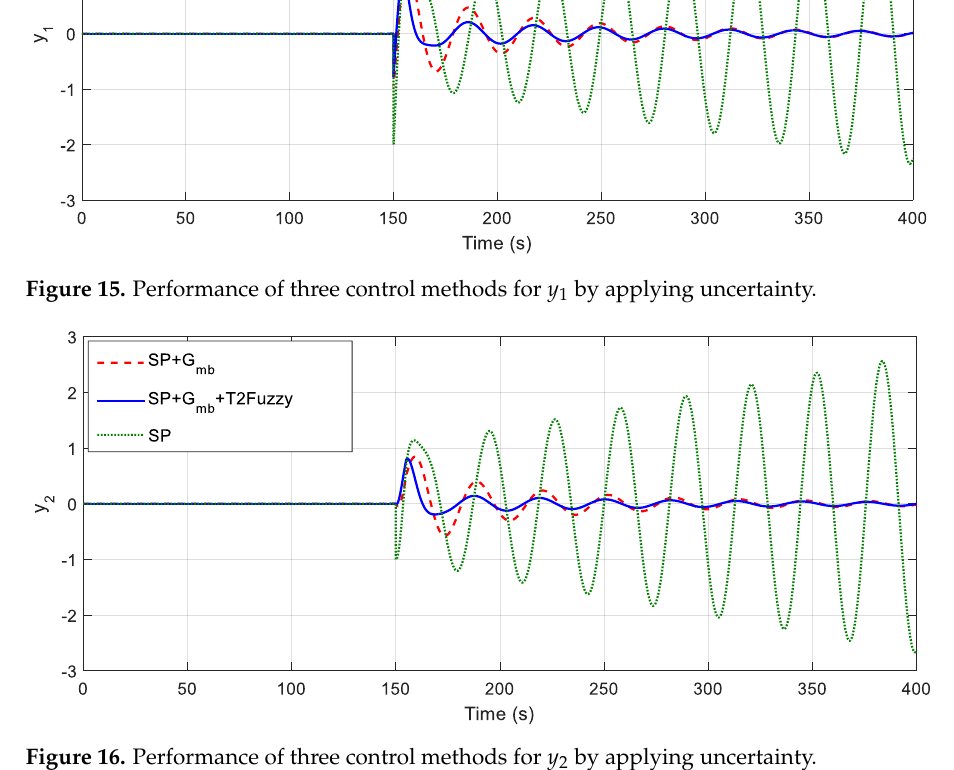
Figure 18. The control signal 𝑢 2 for all three methods by applying uncertainty. Interesting results can be seen in Figures 11 – 18. Smith’s pure prediction method di- verges against large changes in parameters. Since after the initial adjustment of Smith ’s prediction method, it is assumed that the system does not change behavior (or at least changes very little), this method has nothing to say in the face of major changes. On the other hand, it is observed that the convergence of the control system is adjusted by adding the dominant gain transfer function ( 𝐺 𝑚𝑏 ) to Smith ’s predictive method. Finally, with the addition of a type-2 fuzzy estimator to the control system, the accuracy and speed of con- vergence is dramatically improved. It should be noted that for example 1, the phase mar- gin is 43 ° and the gain margin is 18.6 dB. Example 2: A 3 × 3 subsystem of the shell heavy-oil fractionator is as follows [31]: 𝐺(𝑠) = [ 4.05𝑒 −27𝑠 50𝑠 + 1